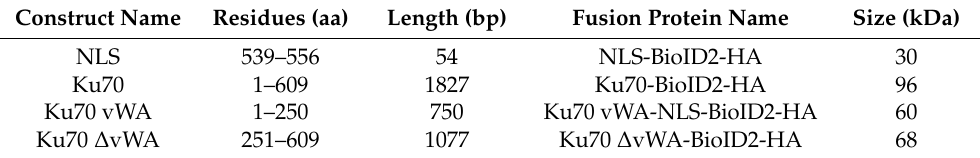
Table 1. BioID2 constructs of various Ku70 segments. A simplified, short form construct name is denoted for each BioID2 fusion protein. NLS specifically refers to the Ku70 nuclear localization signal. Note that the Ku70 vWA also includes the addition of a Ku70 NLS added to its C-terminus, before the biotin